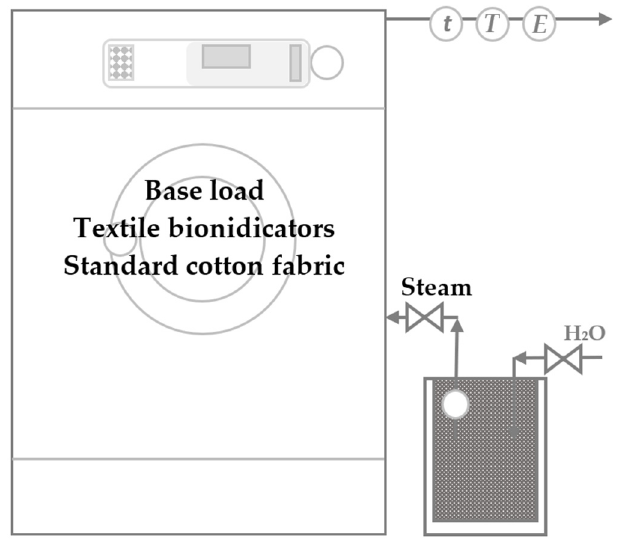
Figure 12. Scheme of the system for the saturated steam treatment.